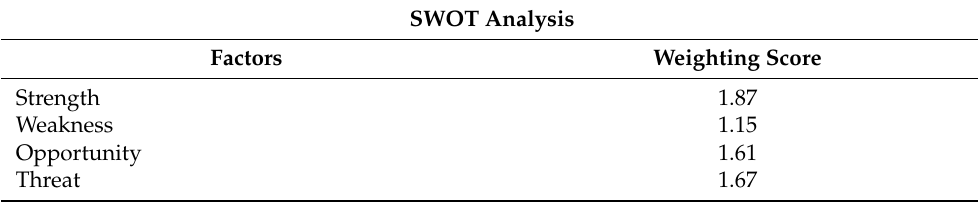
Table 3. Strength, weakness, opportunity and threat of the DBH Sawit revenue-sharing scheme.